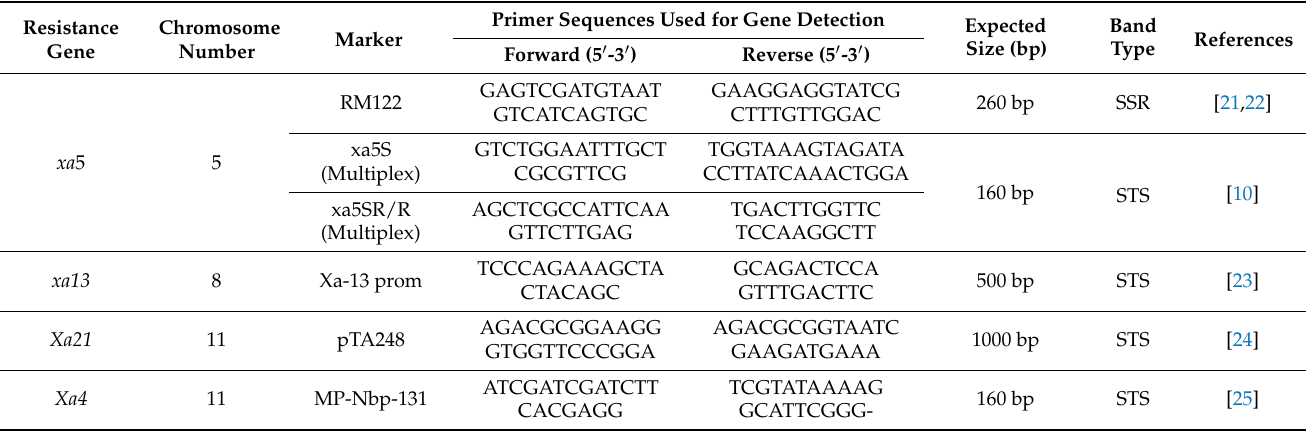
Figure 1. Schematic diagram for introgression of four BB resistance genes, Xa4 , xa5 , xa13 , and Xa21 , into popular rice variety, Ranidhan, through marker-assisted backcross breeding. Table 1. Markers used for foreground selection of four bacterial blight resistance genes in marker-assisted backcross breeding.